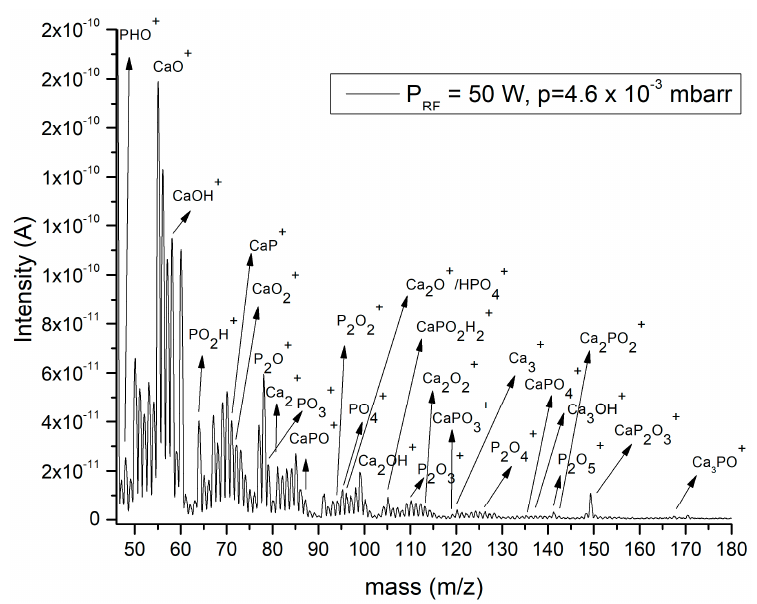
Figure 4. Mass spectrum of the gas extracted from the magnetron plasma discharge.